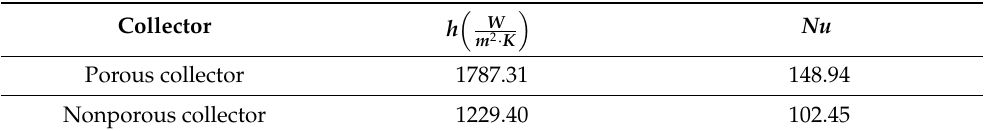
Table 1. The comparison between the convection heat transfer coefficient and the Nusselt number for porous and non-porous collectors, with L = 500 mm.